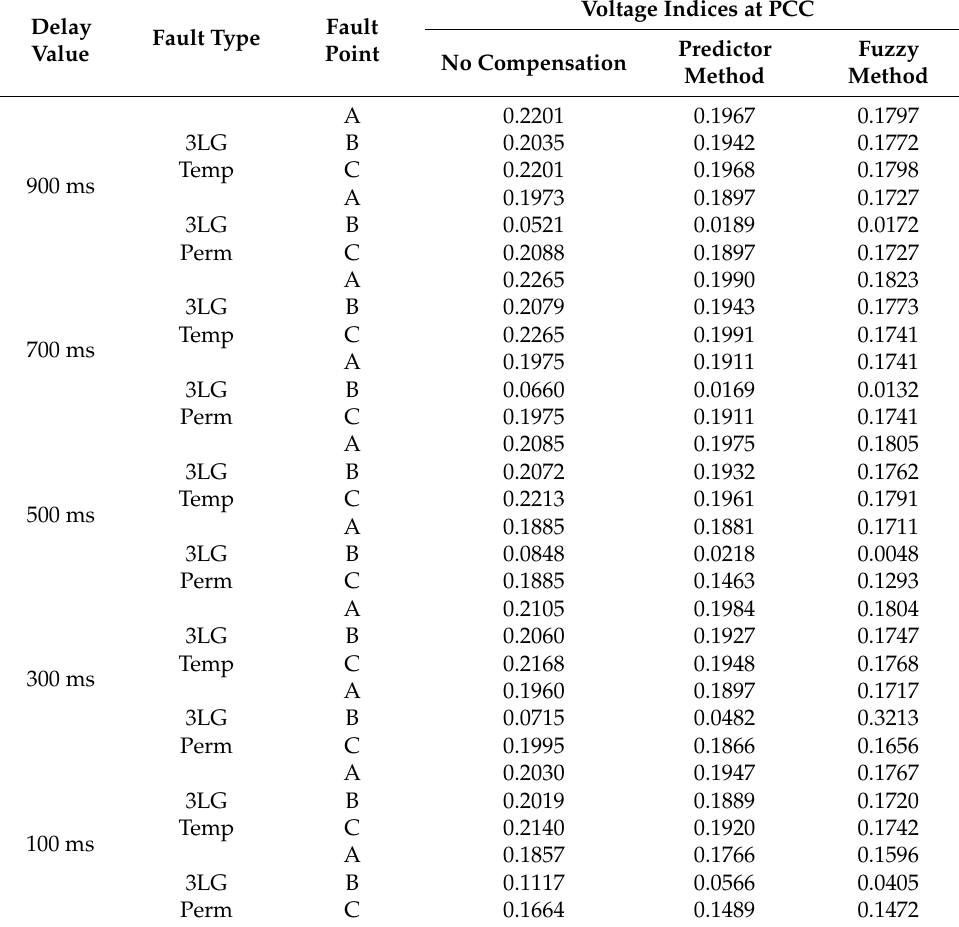
Table 5. Voltage indices at